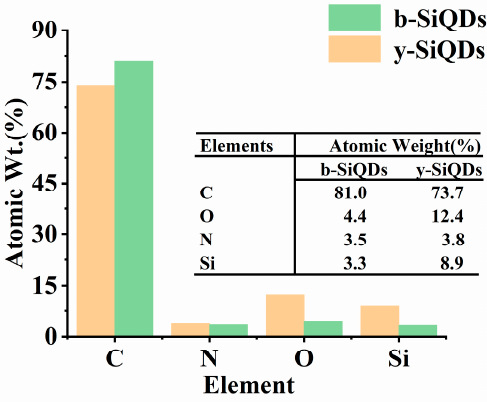
Figure 7. Atomic weight composition (%) of C, N, O, and Si for b-SiQDs and y-SiQDs examined by EDS.